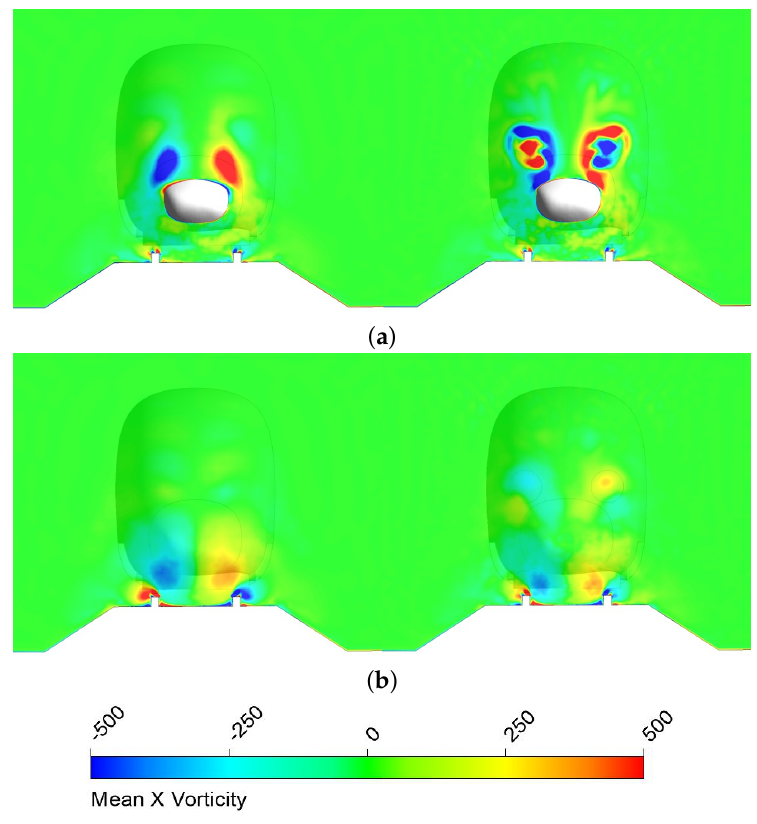
Figure 6. Mean x -vorticity comparison of (left) baseline and (right) circulation injection at planes located ( a ) 0.1 L Ref upstream of tail and ( b ) 1 L Ref downstream of tail.